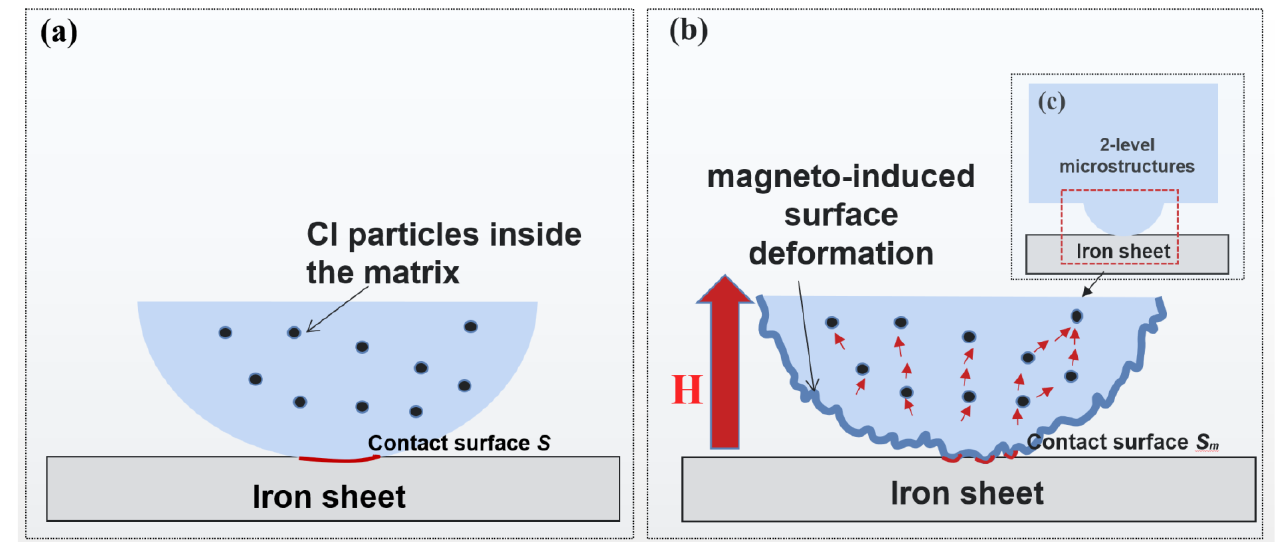
Figure 10. The mechanism of the magneto-responsive adhesion of 2L-MAE detached from the iron sheet. ( a ) the pull-off process without magnetic field in microscopic ( b ) the pull-off process